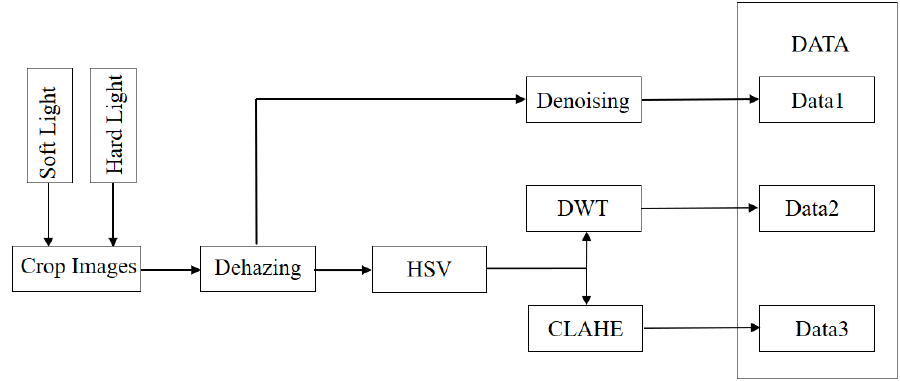
Figure 7. Process of image information enhancement and data set preparation.